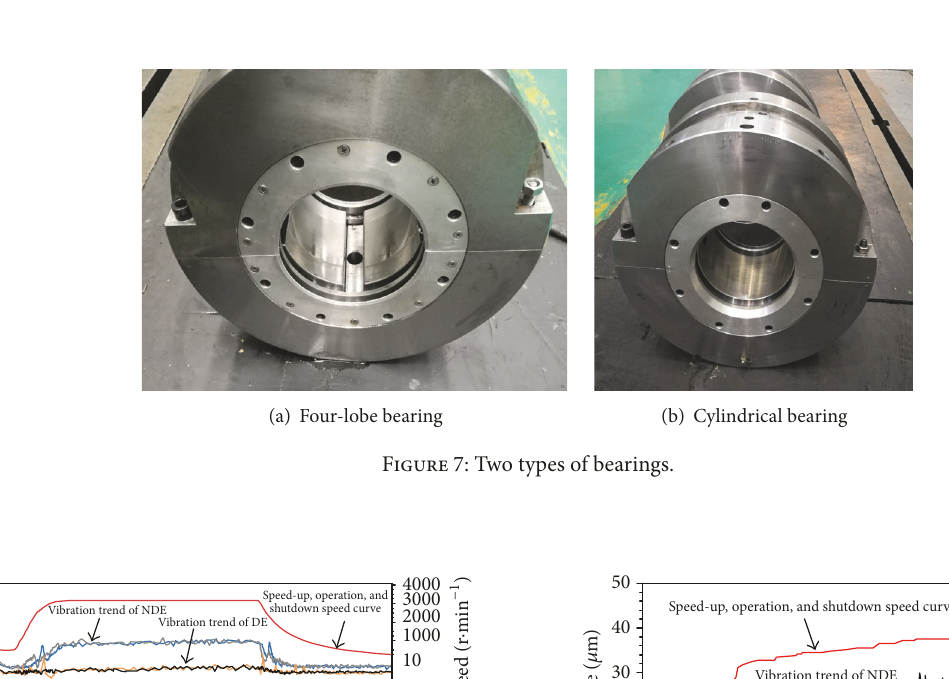
Figure 6: TRT test platform and the installation of vibration and speed probe.